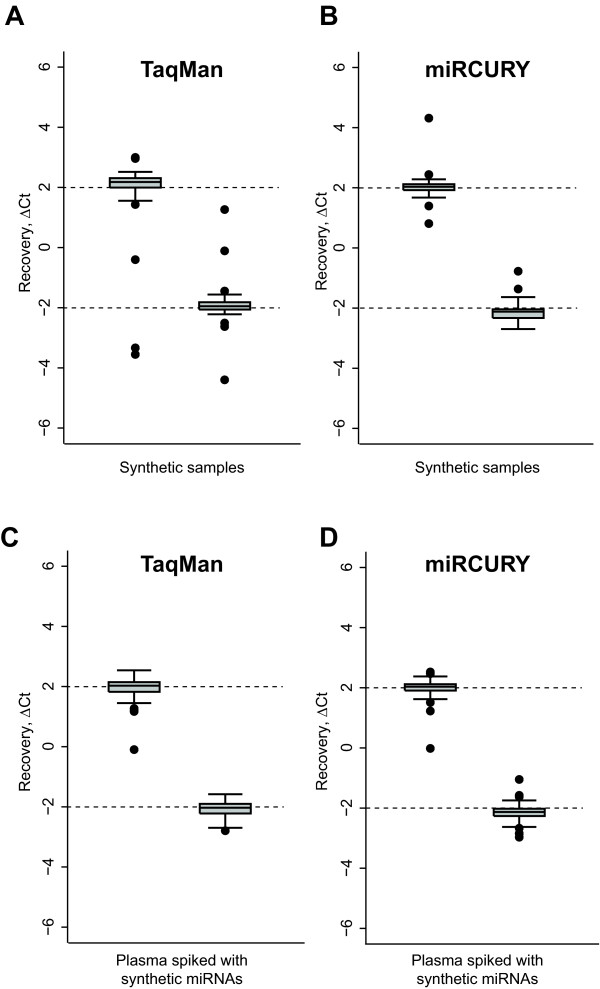
Assessment of the capability of the platforms to recover known miRNA copy number differences. The ability of the platforms to recover known four-fold miRNA copy number differences between samples was assessed by calculating ΔCt's for 125 synthetic miRNAs common to both the TaqMan and miRCURY platforms. Shown are boxplots of the ΔCt's obtained for TaqMan (A, C) and miRCURY (B, D). Recovery was assessed both in the synthetic samples i.e. consisting solely of synthetic miRNAs (A, B) and the plasma RNA samples spiked with synthetic miRNAs (C, D). Separate plots were made for miRNAs that were four fold higher (ΔCt = 2) and lower (ΔCt = -2) in sample 1 compared to 2.